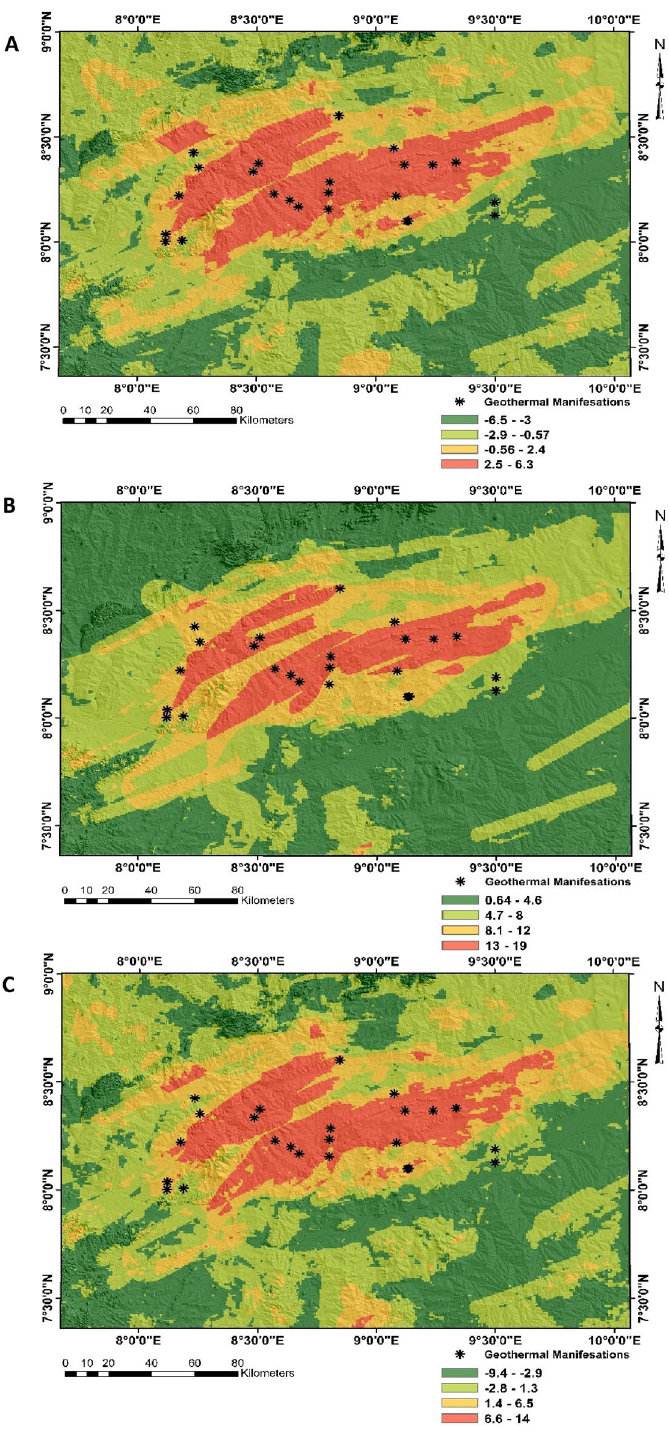
Figure 6. Geothermal predictive maps: ( A ) application of statistical index, ( B ) application of frequency ratio, ( C ) application of weights of